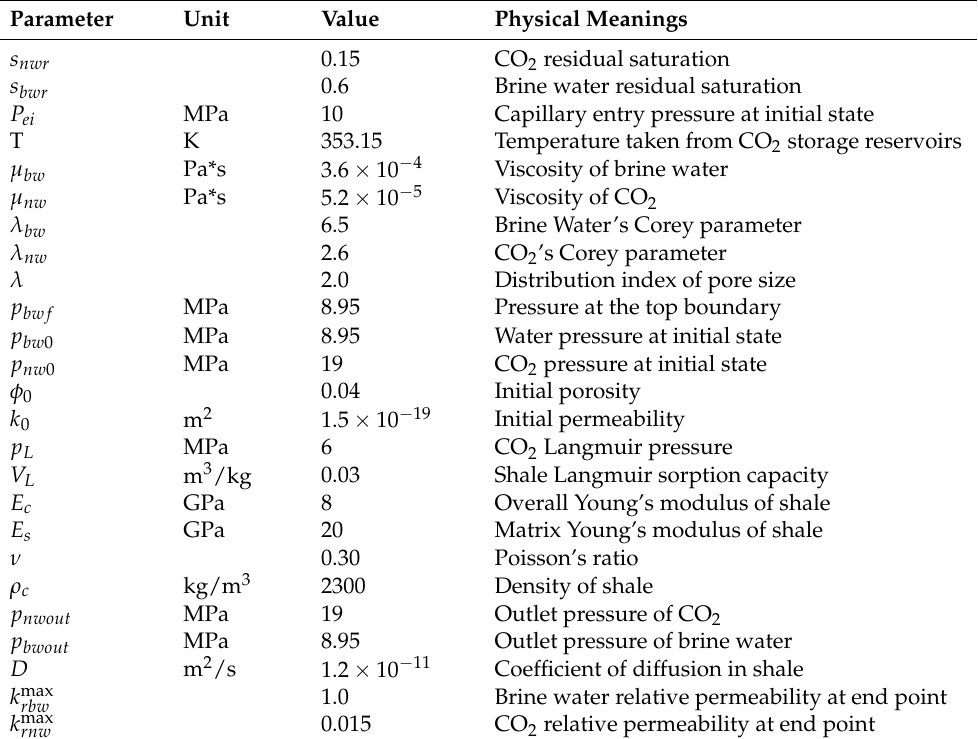
Figure 8. Numerical model for CO 2 -water two-phase flow in caprock. Table 3. Computation parameters for CO 2 penetration.